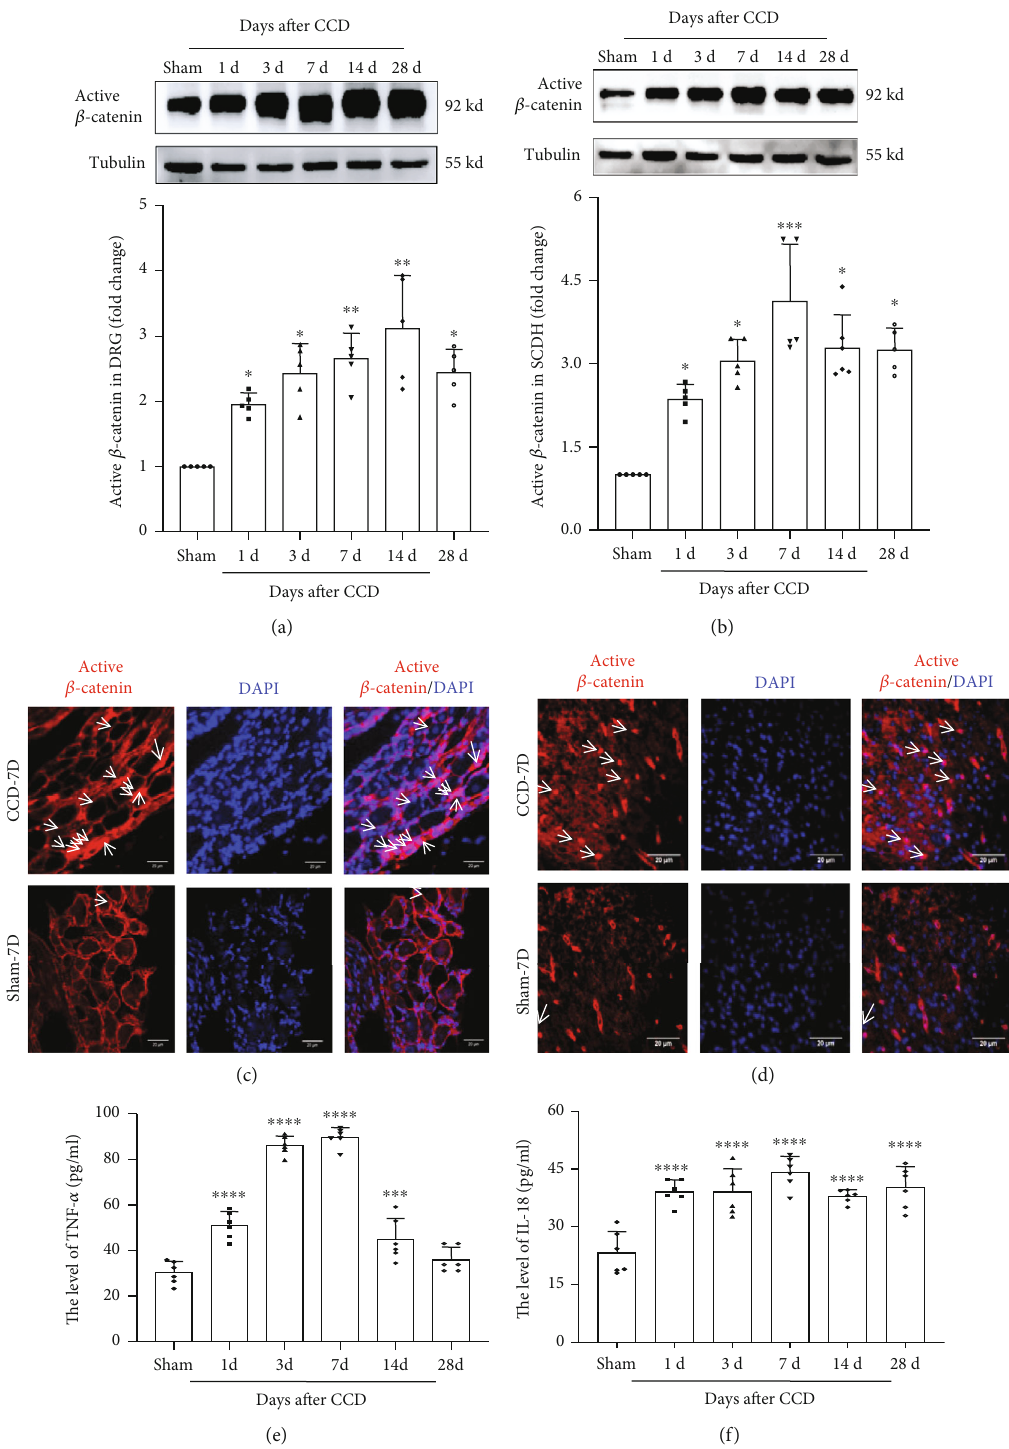
Figure 2: Expression and nuclear translocation of active β -catenin protein in DRG and SCDH and the levels of TNF- α and IL-18 in serum after CCD. Western blot showing the expression of active β -catenin in (a) DRG and (b) SCDH at di ff erent time points. The expression of active β -catenin (red) and its transport of the super fi cial (c) DRG and (d) SCDH into the nucleus (DAPI). Arrows indicate some of the nuclear transport of active β -catenin. Tissues were collected on CCD day 7. The sections were imaged with a (c) fl uorescence microscope and a (d) confocal microscope. Original magni fi cation, scale bars: 20 μ m. ELISA displaying the levels of (e) TNF- α and (f) IL-18 in rat serum at di ff erent time points after CCD ( n = 6 ). Serum was collected on CCD day 7. Bars represent group means ± SD , n = 5 . One-way ANOVA, ∗ P < 0 : 05 , ∗∗ P < 0 : 01 , ∗∗∗ P < 0 : 001 , and ∗∗∗∗ P < 0 : 0001 versus